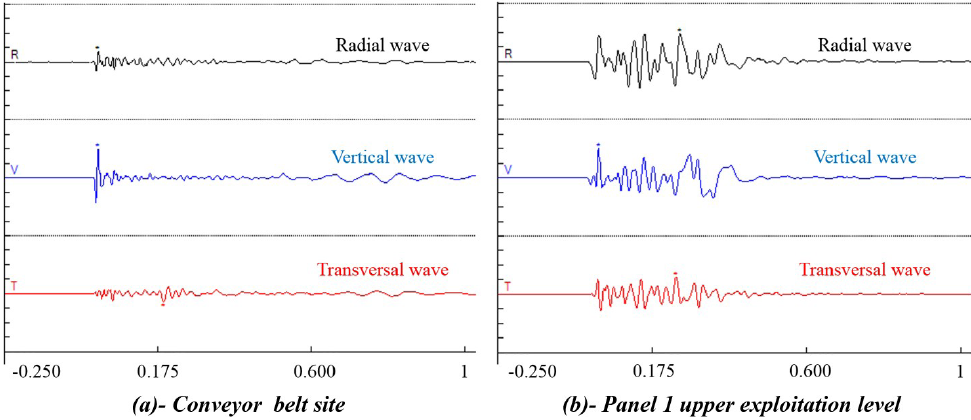
Figure 4: (a) Signal analysis at “Conveyor belt” (charge weight per delay 50 kg – distance from blast 436 m); (b) Signal analysis at “Panel 1 (Upper exploitation level)” (charge weight per delay 50 kg – distance from blast 150